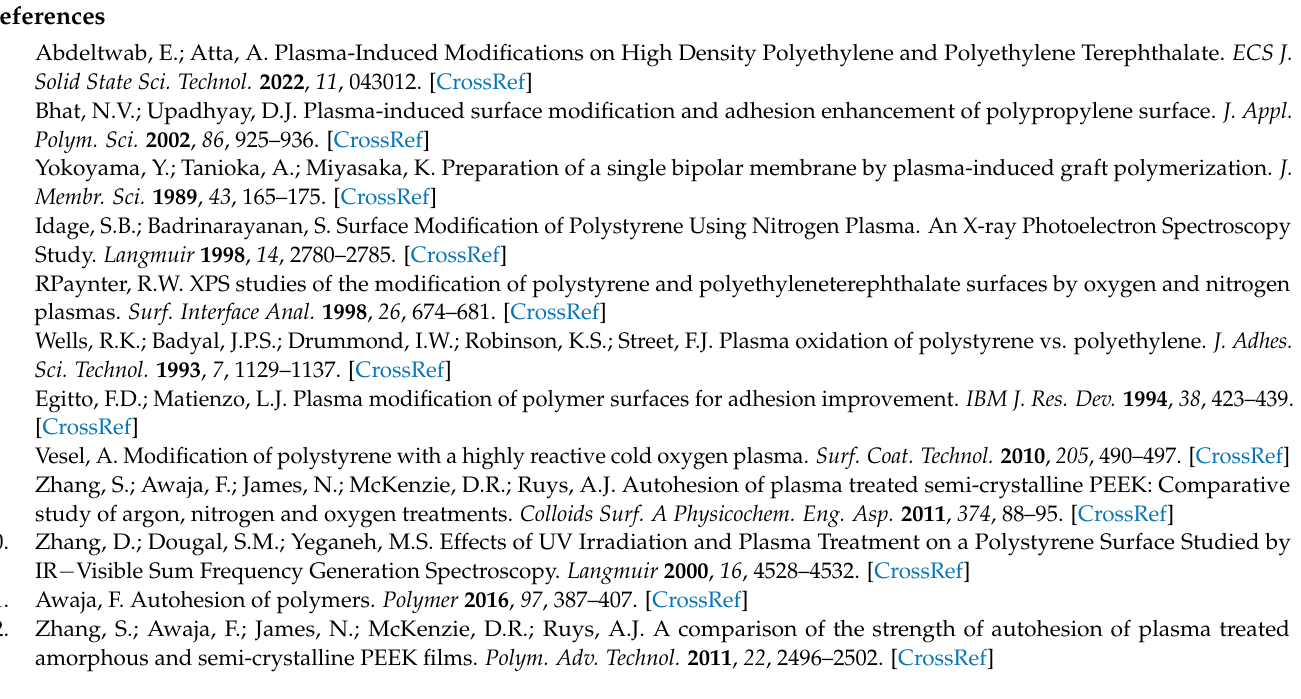
Figure S2: XPS survey spectra of copper(II) loaded